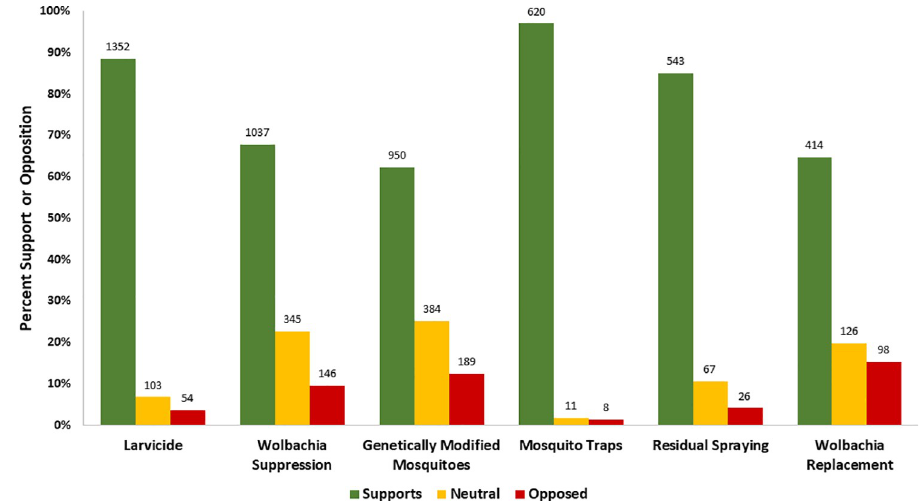
Fig 2. Acceptability of vector control interventions, COPA, Ponce, Puerto Rico,